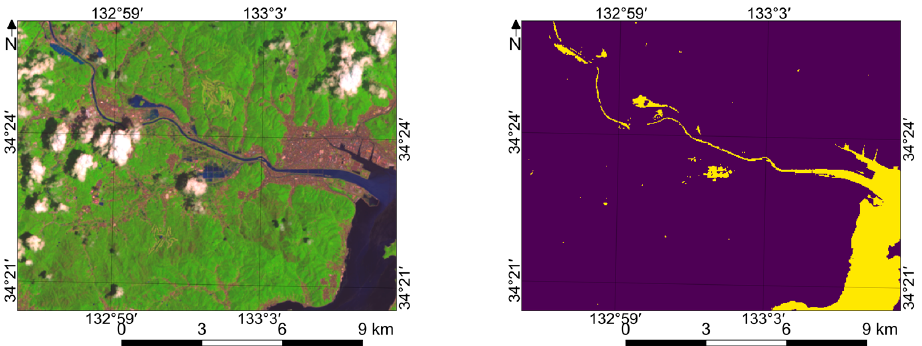
Figure B3. Flood-inundated muddy water extracted during the Hiroshima flood, July 2018.